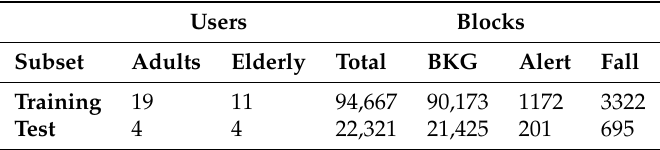
Table 2. Dataset distribution for each subset.